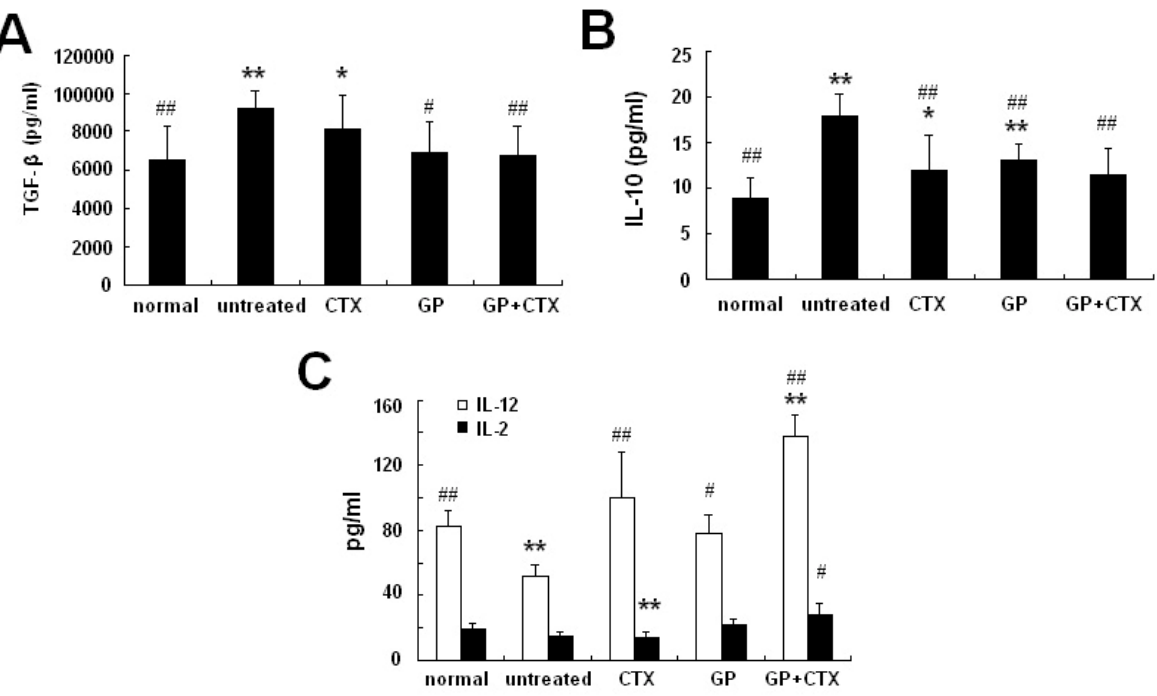
Figure 4. Effects of GP on IL-2, IL-12p70, IL-10 and TGF- β production in the serum of tumor-bearing mice. ( A ) Concentration of TGF- β in serum. ( B ) Concentration of IL-10 in serum. ( C ) Concentration of IL-2 and IL-12p70 in serum. Cytokines were determined using ELISA. All experiments were performed three times. * P < 0.05, ** P < 0.01, vs.